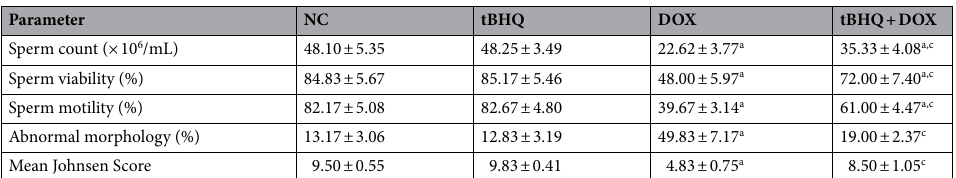
Table 2. Sperm parameters in the different experimental groups. Values are mean ± SD, n = 6/group. NC: normal control, tBHQ: tert-butylhydroquinone, DOX: doxorubicin. a p < 0.05 versus NC group, c p < 0.05 versus DOX group (One-way ANOVA with Tukey’s post-hoc